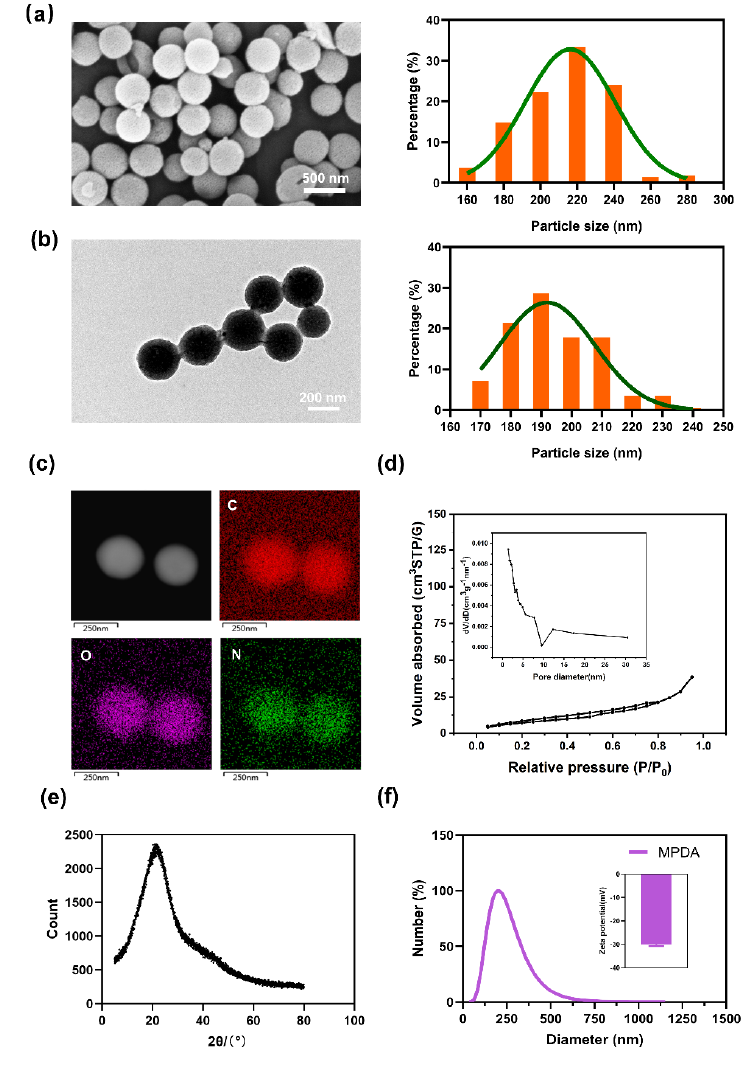
Figure 1. Characterization of MPDA. ( a ) SEM image and the SEM-extracted diameter distribution histogram. ( b ) TEM image and the TEM-extracted diameter distribution histogram. ( c ) Elemental mapping of MPDA. ( d ) N 2 adsorption–desorption isotherms and the pore diameters of MPDA. ( e ) XRD patterns. ( f ) Size distribution and zeta potentials.